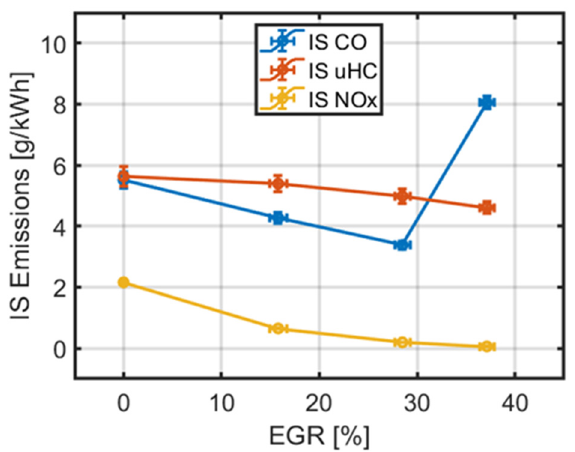
Figure 9. Indicated specific emissions of CO (IS CO), IS uHC, and IS NOx vs. external, cooled exhaust gas recirculation (EGR).